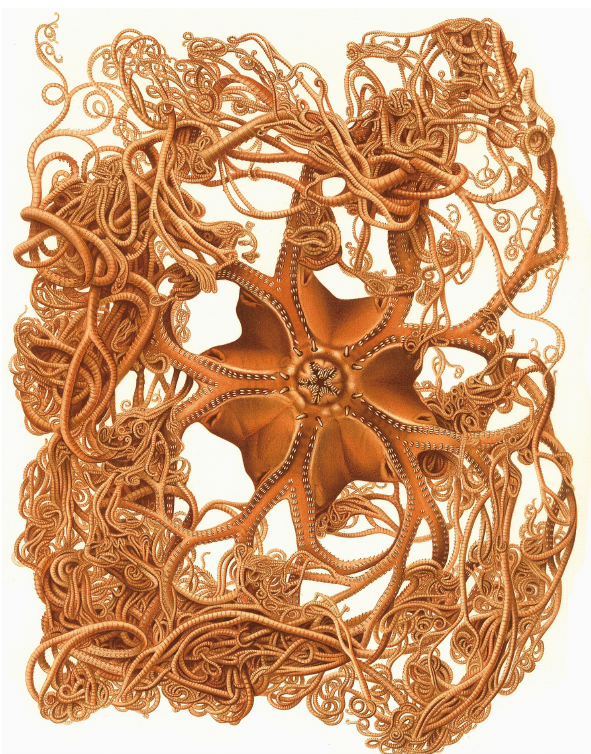
Figure 1. Gorgonocephalus arcticus (Leach, 1819) (from Koehler 1909, pl. 9; as Gorgonocephalus agassizi ; Stimpson, 1854). This is the species that was caught during the John Ross